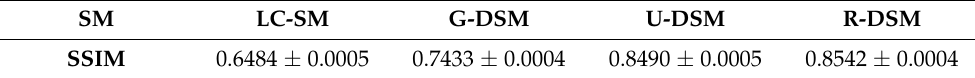
Table 2. SSIM (mean ± SD) with FC-SM of LC-SMs, G-DSMs, U-DSMs, and R-DSMs for 99m Tc.